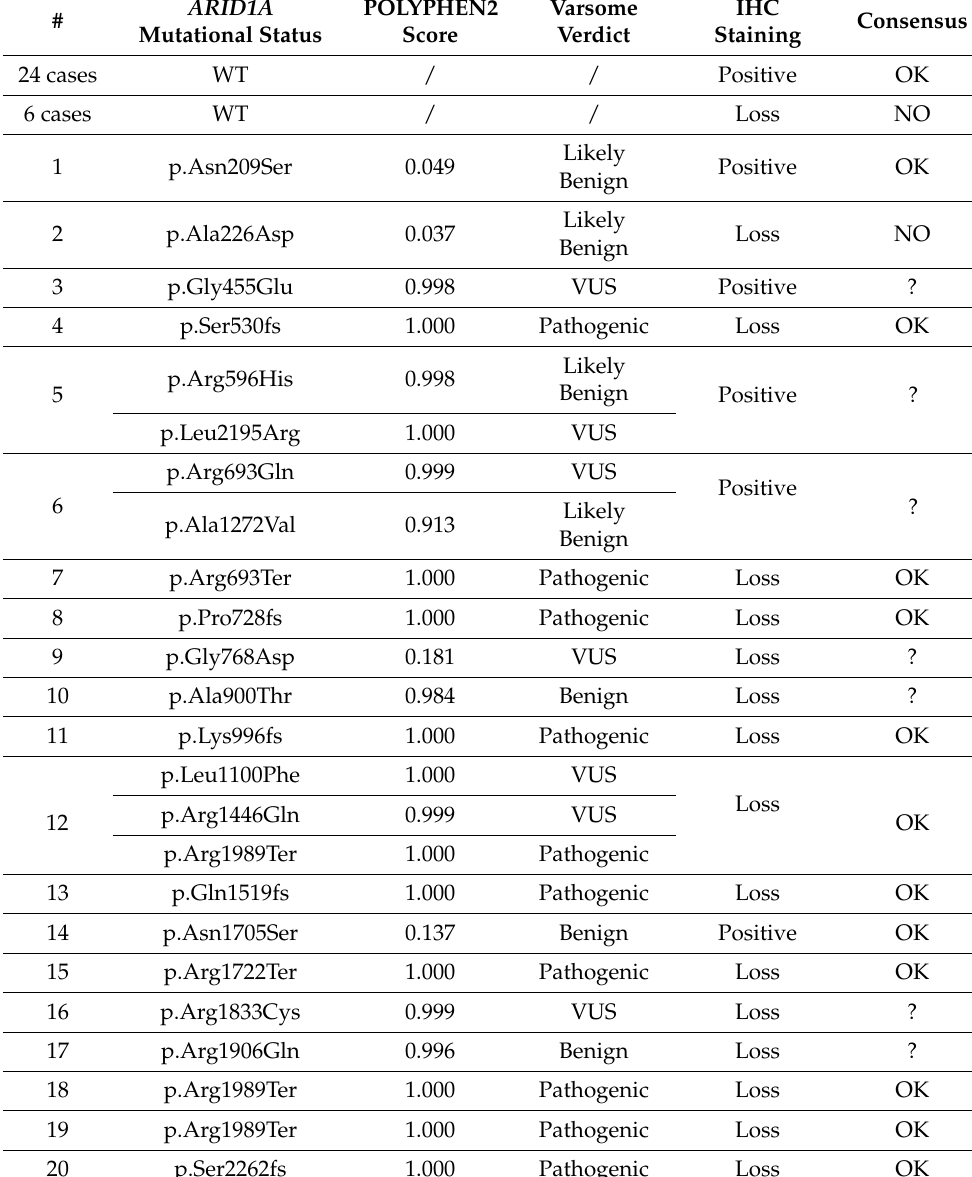
Table 5. Comparison between ARID1A mutational status, in silico prediction effect, and ARID1A pro- tein expression. WT: Wild-Type; IHC: immunohistochemistry; VUS: Variant of uncertain